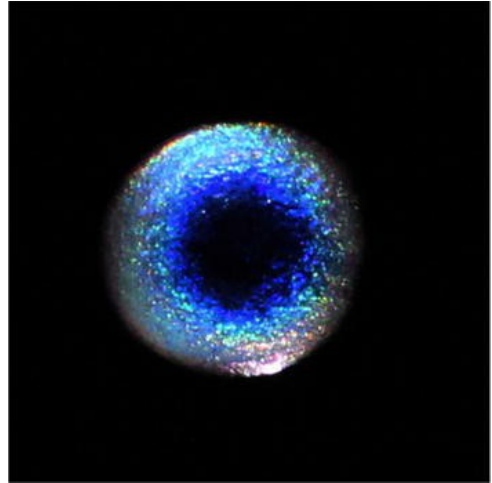
Figure 9: Digital image of dried CNC film showing iridescent proper- ties. Reproduced from [107] with permission of Springer